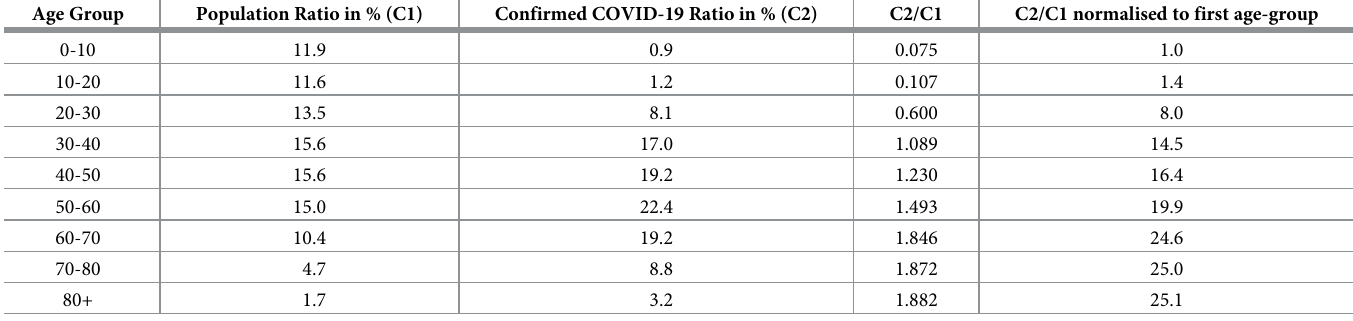
Table 5. Population distribution in China and the distribution of confirmed COVID-19 cases in China as of Feb. 11th. To normalise the distribution of confirmed cases, we can divide the values over the population ratio of that age-group. The resulting values are then used in the optimisation scheme designed to estimates the parame- ters of the epidemiological